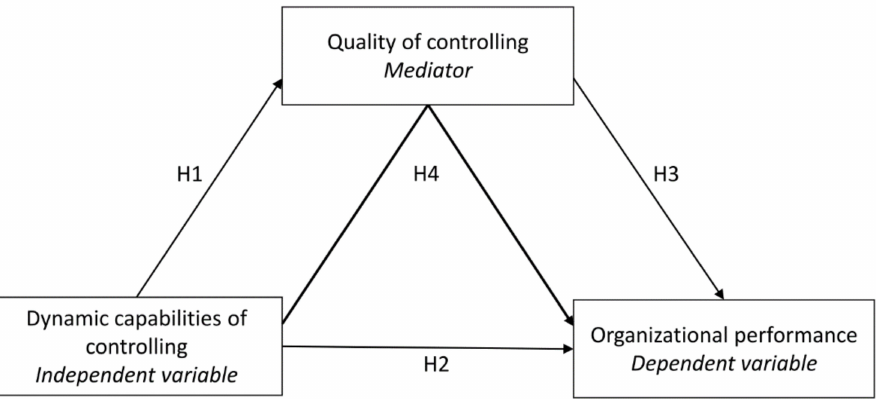
Figure 1. Mediation model of DC of controlling influence on organizational performance; source: own